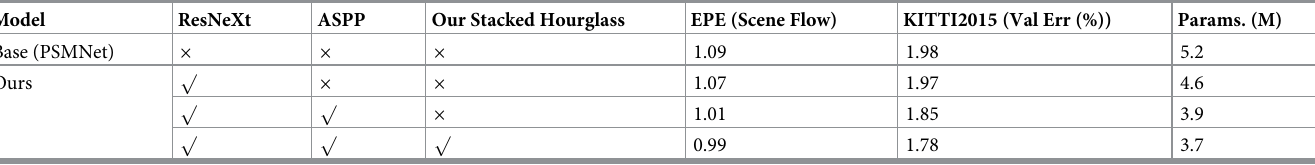
Table 3. The results of the ablation comparison on Scene